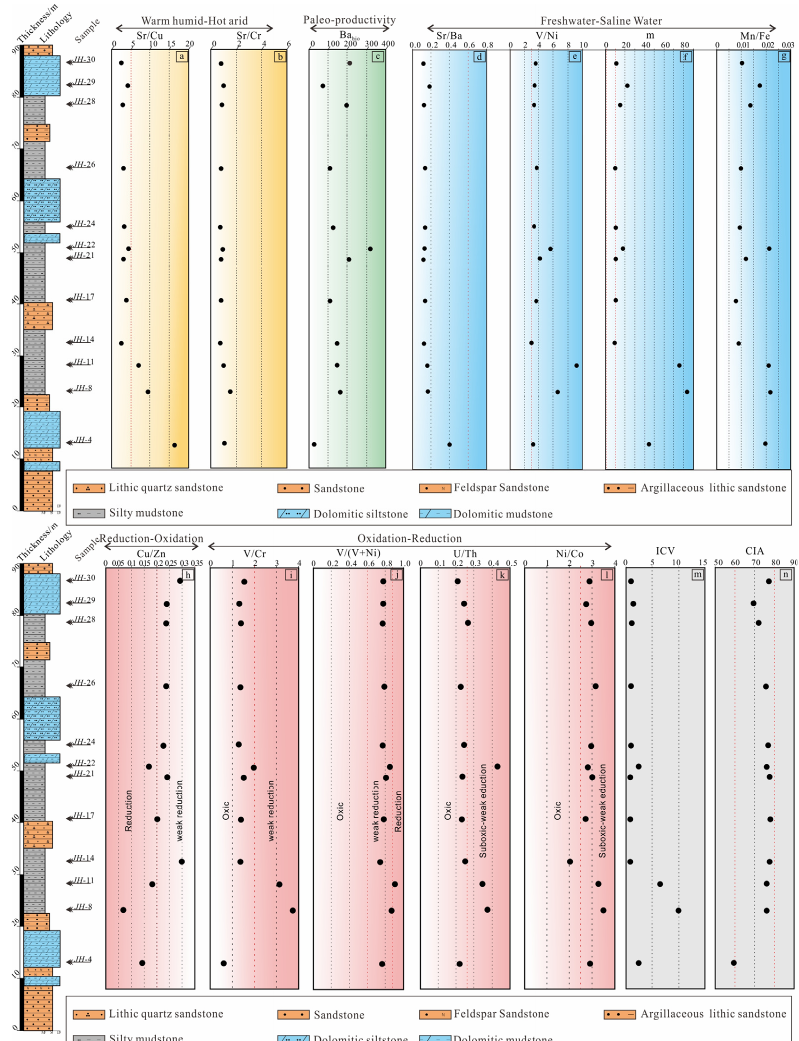
Figure 8. Profiles of paleoclimatic (Sr/Cu and Sr/Cr), paleo-productivity (Ba bio ), paleo-salinity (Sr/Ba, V/Ni, m, and Mn/Fe), paleo-redox (Cu/Zn, V/Cr, V/(V + Ni), U/Th, and Ni/Co) and chemical weathering degree (ICV and CIA) changes in the JH section of the Xu-3 Member. ( a , b ) Change trend of the paleoclimate in the JH section; ( c ) Change trend of paleo-productivity Ba bio in the JH section. ( d ) Change trend of Sr/Ba in paleo-salini; ( e ) Change trend of V/Ni in paleo-salinity; ( f ) Change trend of m in paleo-salinity; ( g ) Change trend of Mn/Fe in paleo-salinity; ( h ) Change trend of Cu/Zn in paleo-redox; ( i ) Change trend of V/Gr in paleo-redox; ( j ) Change trend of V/(V + Ni) in paleo-redox; ( k ) Change trend of U/Th in paleo-redox; ( l ) Change trend of Ni/Co in paleo-redox; ( m ) Change trend of ICV in chemical weathering degree;. ( n ) Change trend of CIA in chemical weathering